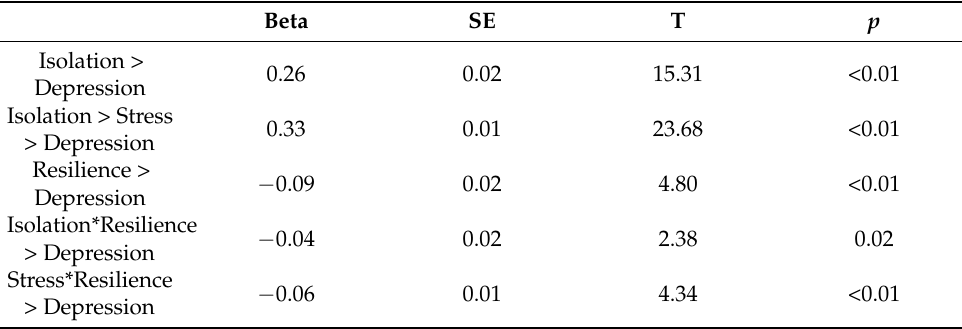
Table 4. Results of bootstrapping for direct/indirect effects